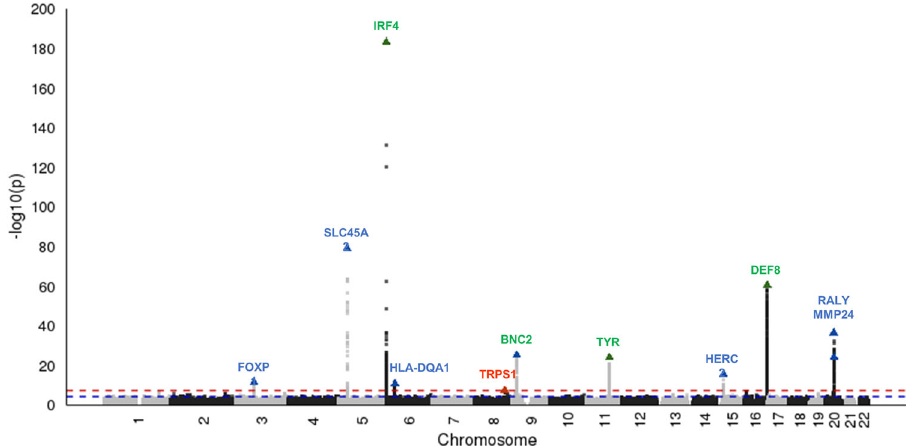
Fig. 3 Manhattan plot of GWAS meta-analysis of actinic keratosis combining results of GERA and MGB Biobank cohorts ( n = 92,240). The y axis represents log-scale P -values, and loci with the smallest P obtained from the logistic regression are labeled with the nearest or corresponding gene ’ s name. Known loci are in green triangles, newly identi fi ed loci in discovery analysis are in blue triangles, and newly identi fi ed loci in meta-analysis are in orange